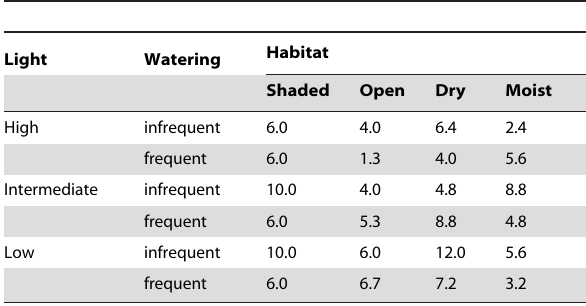
Table 3. Mean seedling mortality values in percentages per habitat and treatment.